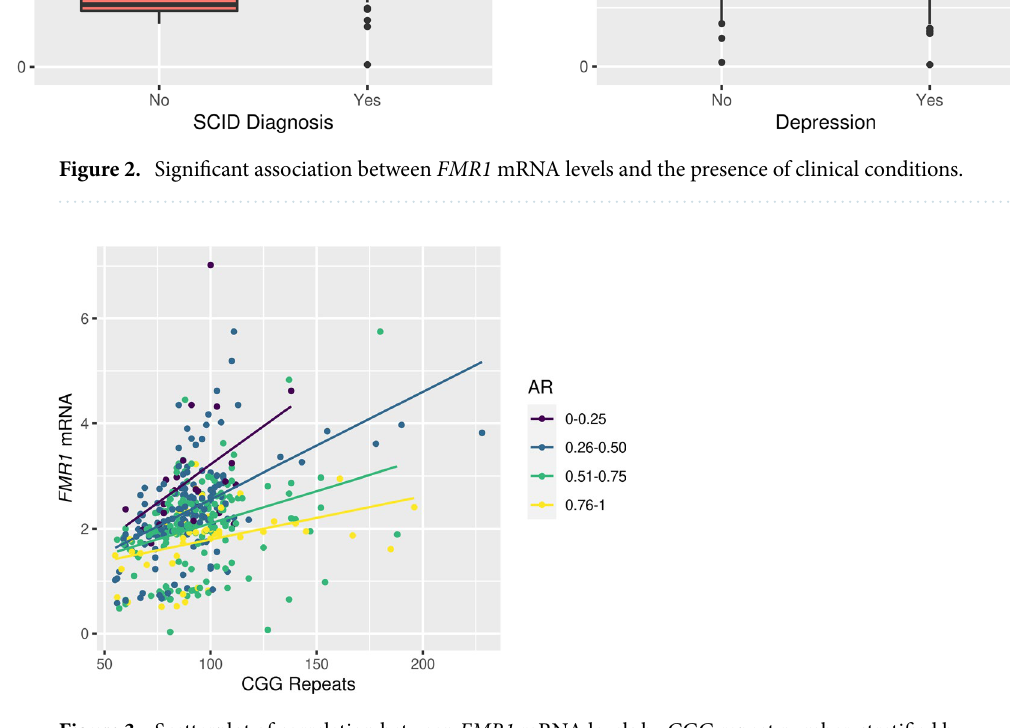
Figure 3. Scatterplot of correlation between FMR1 mRNA levels by CGG repeat number, stratified by activation